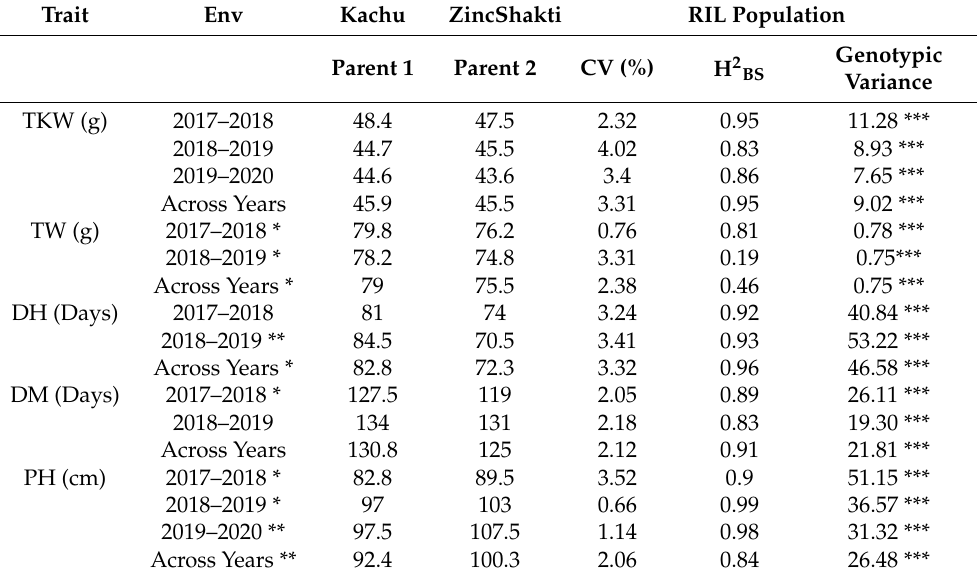
The t -test results indicating significant difference between parents for each trait are provided in the environment column. * significant values at p < 0.05, ** significant values at p < 0.01, *** significant values at p <